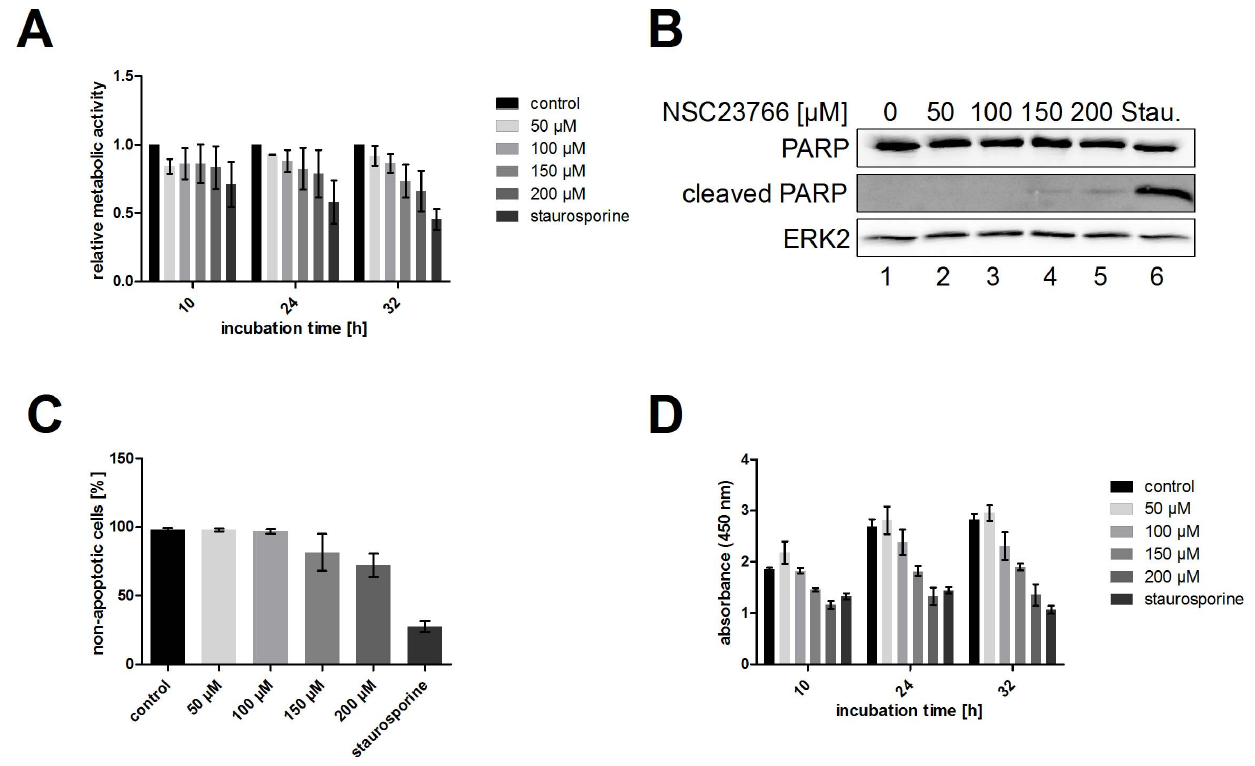
Figure 2. NSC23766 does not cause cytotoxic side-effects on A549 cells. A549 cells were treated with the indicated concentrations of NSC23766 or staurosporine (1 m M), which served as a positive control. After 10, 24, or 32 h incubation, metabolic activity was measured via MTT assay (A). The onset of apoptosis was analyzed after 24 h incubation either by the detection of PARP cleavage in Western blot analysis (B) or by propidium iodide staining (C). Cell proliferation was determined after indicated incubation times by usage of the cell proliferation reagent WST-1 detecting the absorbance at 450 nm (D). Data represent means 6 SD of three independent experiments including four (A) or two (C) biological samples or means 6 SD of three biological samples of one representative out of three conducted experiments